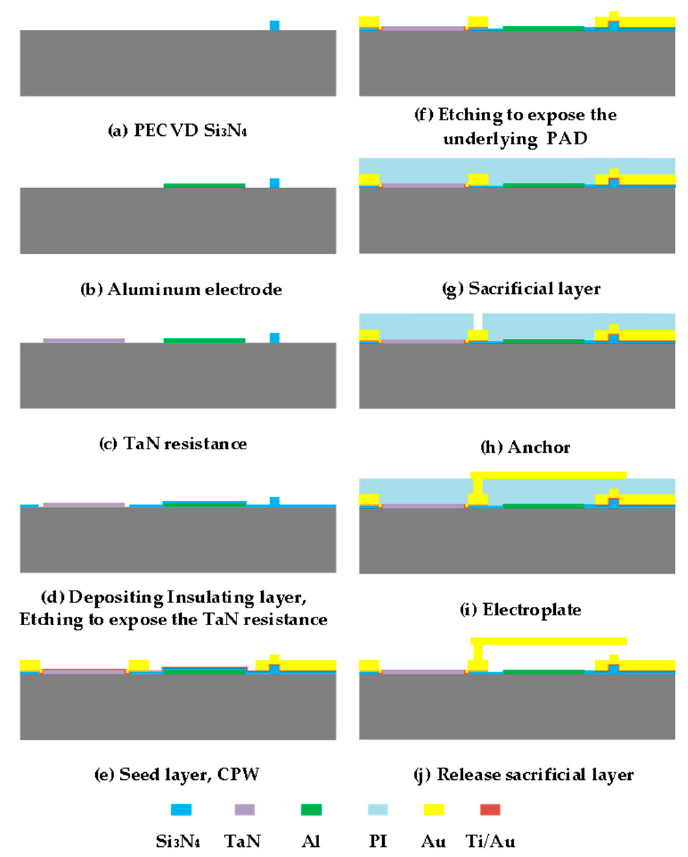
Figure 3. Device process flow.